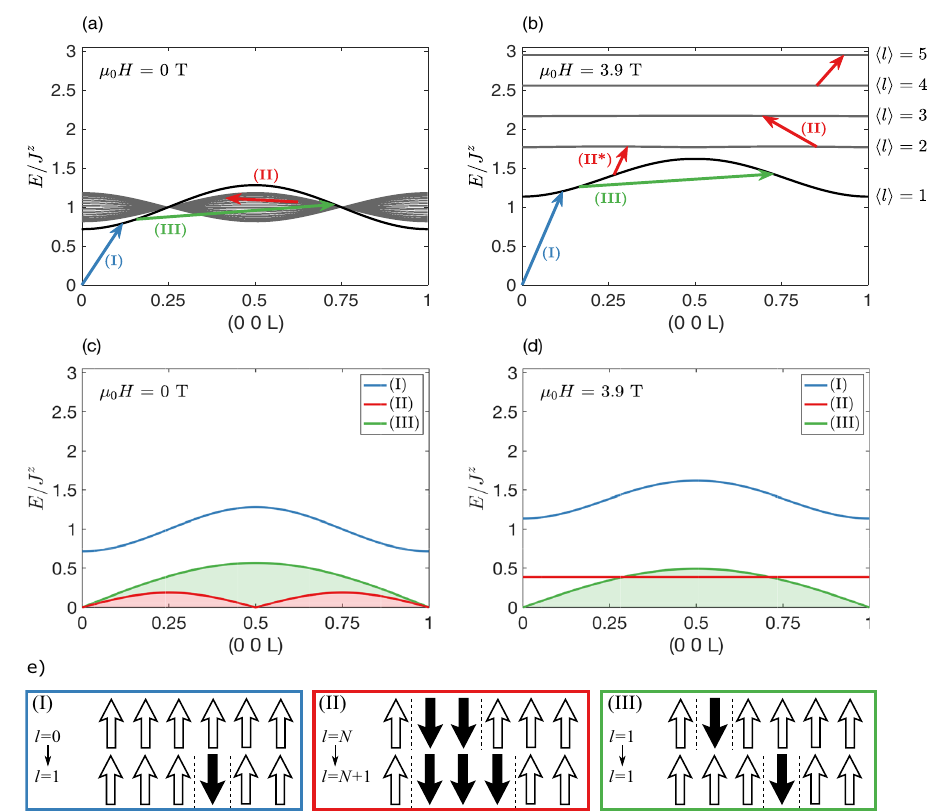
Fig. 1 Cluster energy levels and magnetic excitations for a single chain. Using the parameters J a = J z ¼ 0 : 05, J ? = J z ¼ 0 : 12, J z ¼ 3 : 845 meV and g z = 6.602 relevant for a single chain in CoCl 2 ⋅ 2D 2 O. Panels a and b show calculated cluster eigenenergies in zero fi eld, μ 0 H z = 0, and in the high fi eld limit where the WZL is well-developed, μ 0 H z = 3.9 T. The energy of the ferromagnetic ground state is set to E = J z ¼ 0. L is the momentum transfer component along the reciprocal lattice vector c * ( Q = L ⋅ c * ). c , d Interactions with neutrons cause three distinct types of transitions between the cluster eigenstates, shown by arrows in a and b and illustrated in e . Each gives rise to a contribution to the dynamic structure factor, shown in c and d . e -(I) Creation of a 〈 l 〉 = 1 (single spin- fl ip) cluster leads to single-magnon scattering. e -(II) Transitions between cluster states characterised by different 〈 l 〉 can move a DW by one site. In zero fi eld, this yields a continuum of periodicity 0.5 r.l.u., while in a magnetic fi eld it causes a well de fi ned MBO mode. The transition from 〈 l 〉 = 1 to 〈 l 〉 = 2 states is a special case and is marked by the symbol (II*). e -(III) Intracluster-level transitions for the 〈 l 〉 = 1-cluster are re fl ected in a nearly fi eld-independent continuum of period 1